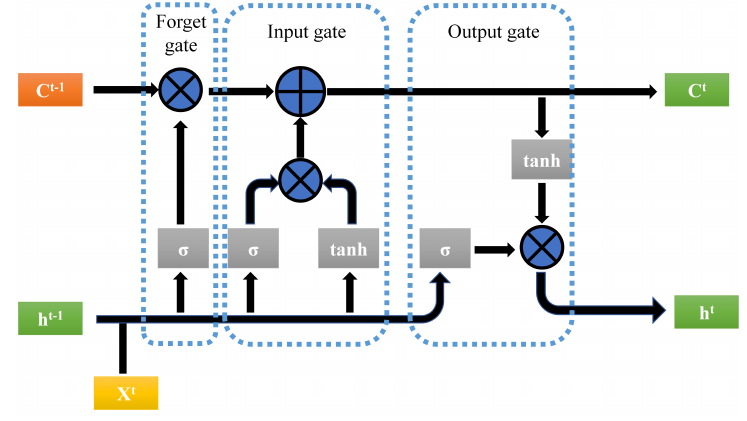
Figure 8. Schematic of LSTM block.